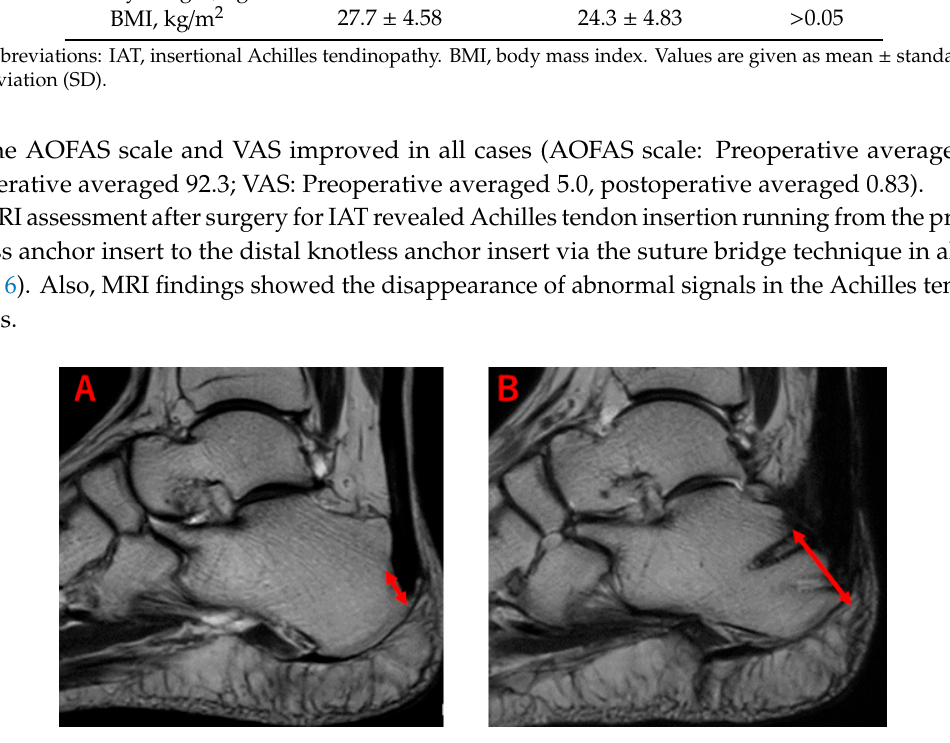
Figure 6. The MRI images of T2-weighted images of the same patient. ↔ : Length of Achilles tendon insertion. ( A ): Pre-operation of the Achilles tendon insertion. ( B ): Post-operation of the Achilles tendon insertion. We can see the postoperative Achilles tendon insertion presence from the proximal knotless anchor insert to the distal knotless anchor insert.